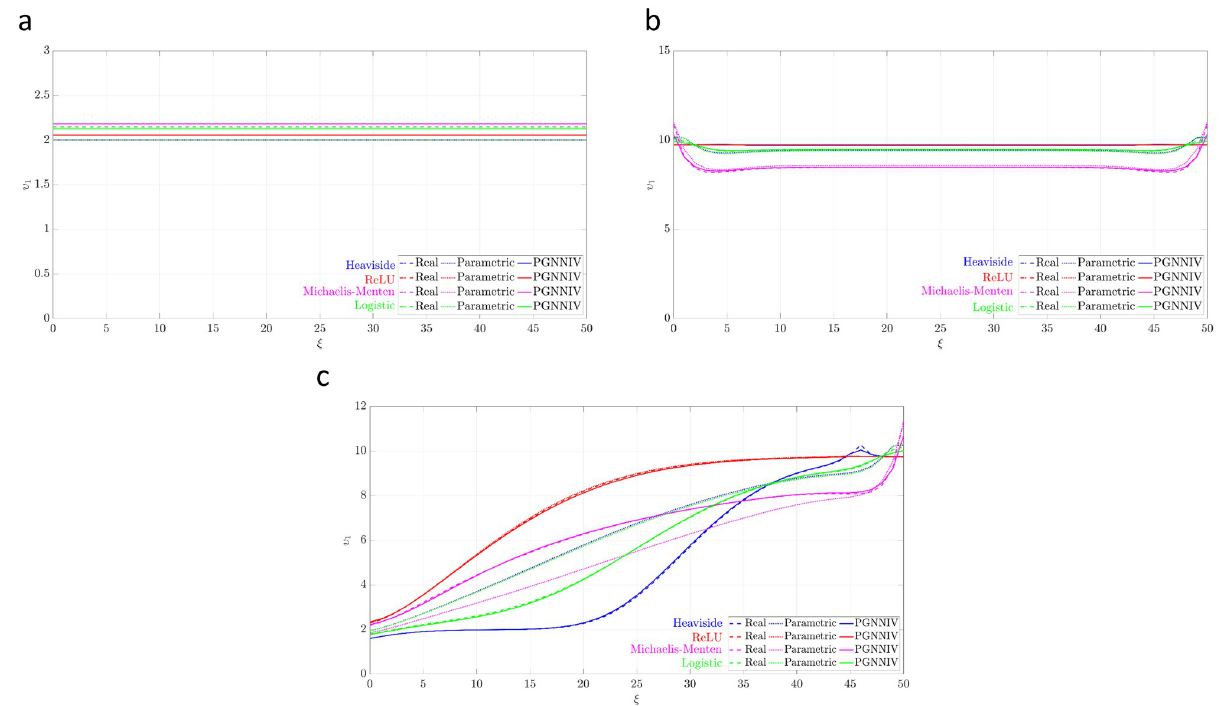
Fig 6. Prediction of the cell profile at τ � = 10 for the different models tested and different experimental configurations. PGNNIV improves the prediction (when compared to the parametric model) of all cell profiles, slightly for the normoxic configuration and significantly for the gradient configuration. ( a ) Hypoxic configuration. ( b ) Gradient configuration. ( c ) Normoxic configuration.